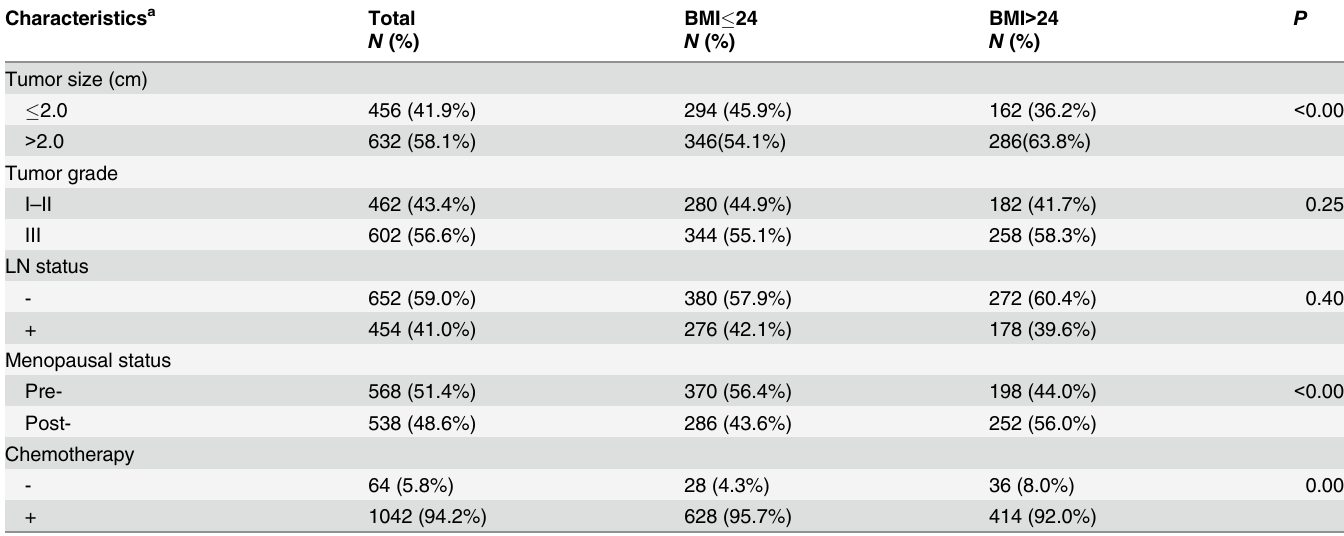
Table 1. Baseline characteristics of